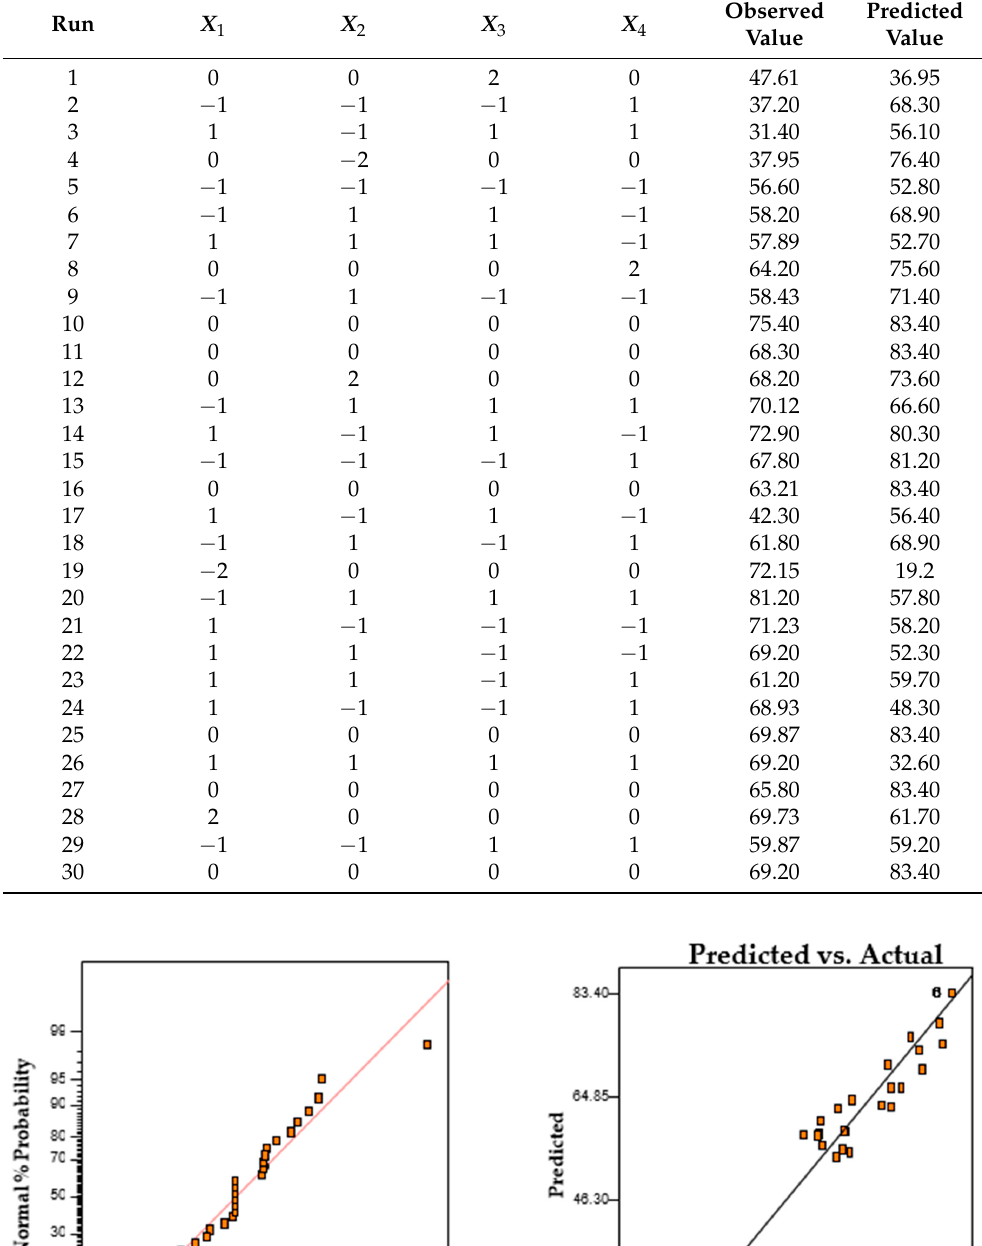
Table 2. Central composite design matrix.